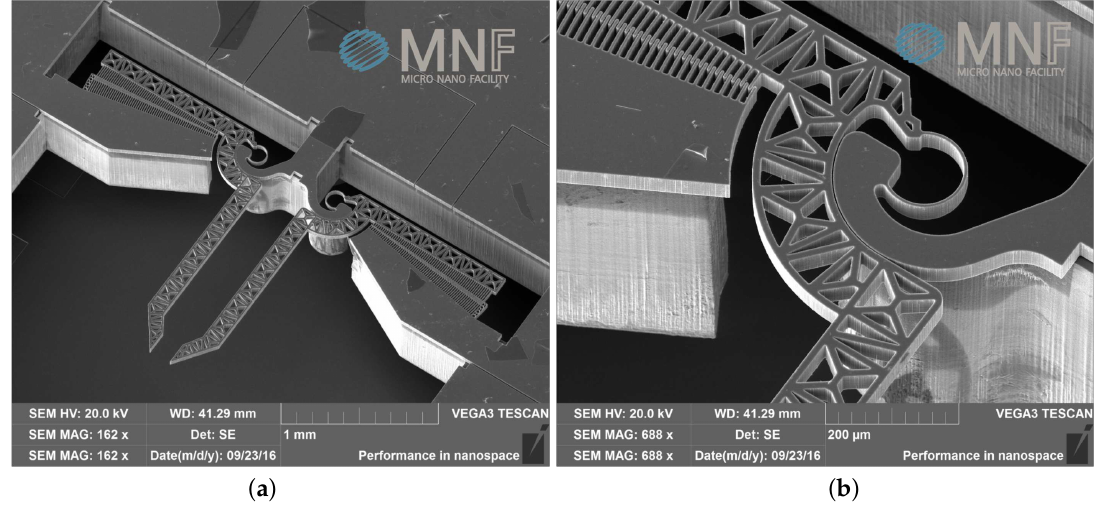
Figure 1. A SEM image of ( a ) the mechanical component of the microsystem and ( b ) a detailed vew of the CSFH